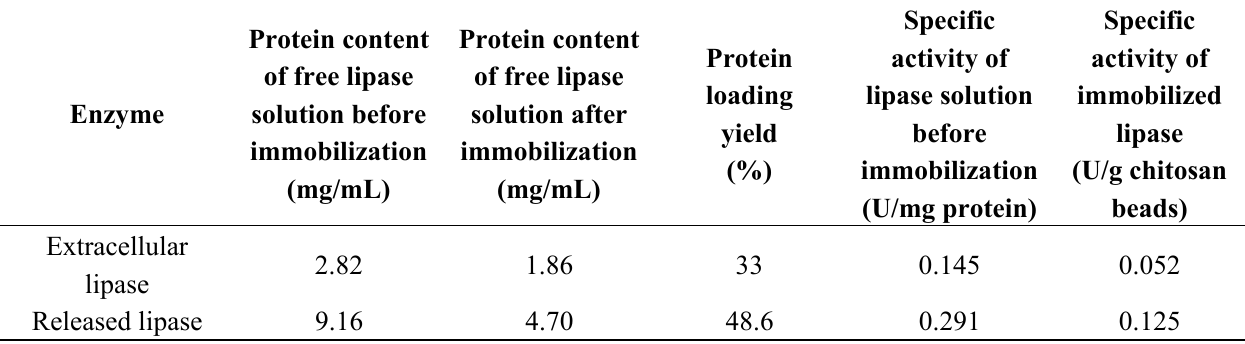
Table 1. Yields of protein loading and activity of lipase immobilized to chitosan beads.